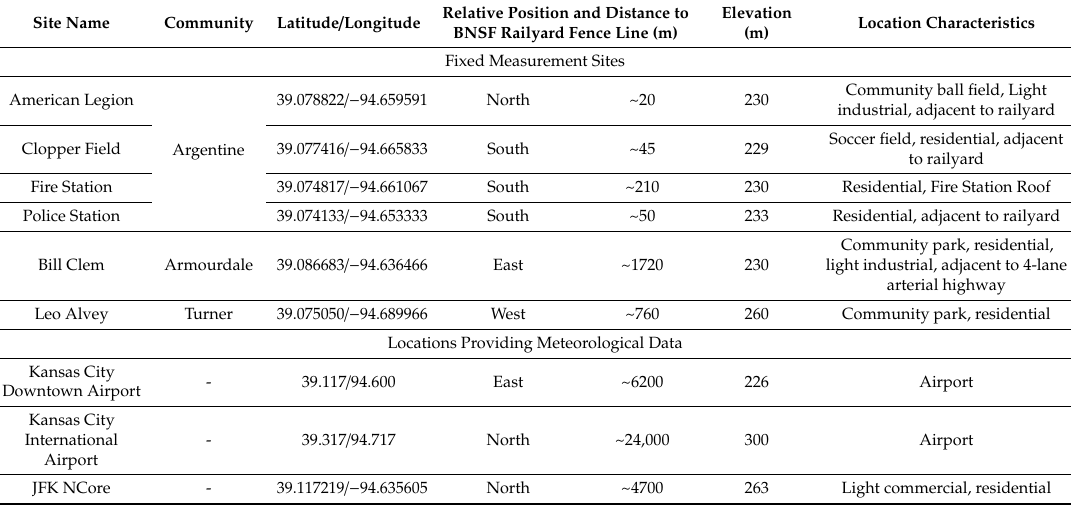
Table 1. KC-TRAQS Fixed Measurement Sites and Locations Providing Meteorological Data. BNSF: Burlington Northern and Santa